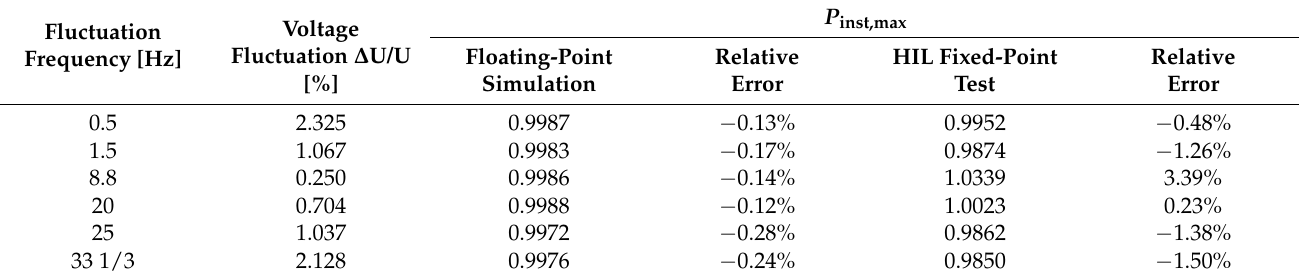
Table 2. Response to sinusoidal voltage fluctuations.